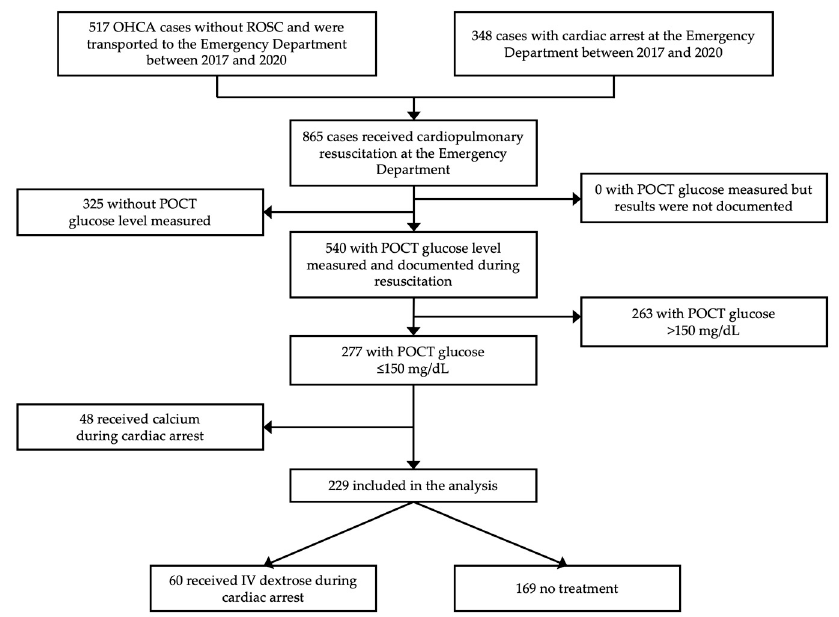
Figure 1. Study flow diagram of the study cohort. IV, intravenous; OHCA, out-of-hospital cardiac arrest; POCT, point-of-care testing; ROSC, return of spontaneous circulation . Table 1. Baseline characteristics, clinical features, and interventions of the study cohort.